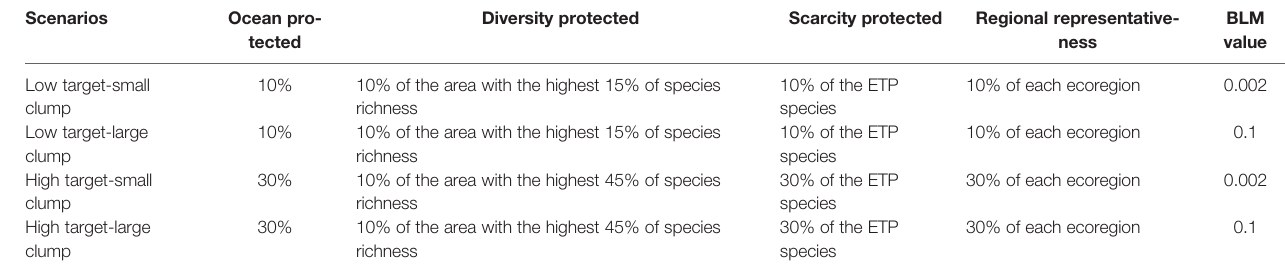
TABLE 2 | Four scenario settings used in the Marxan analysis.